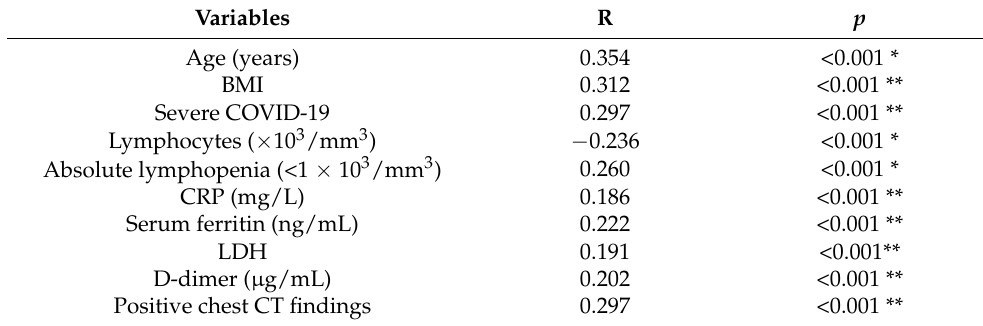
Table 3. Correlation between presence of newly diagnosed DM and different clinical and laboratory parameters ( n = 570).